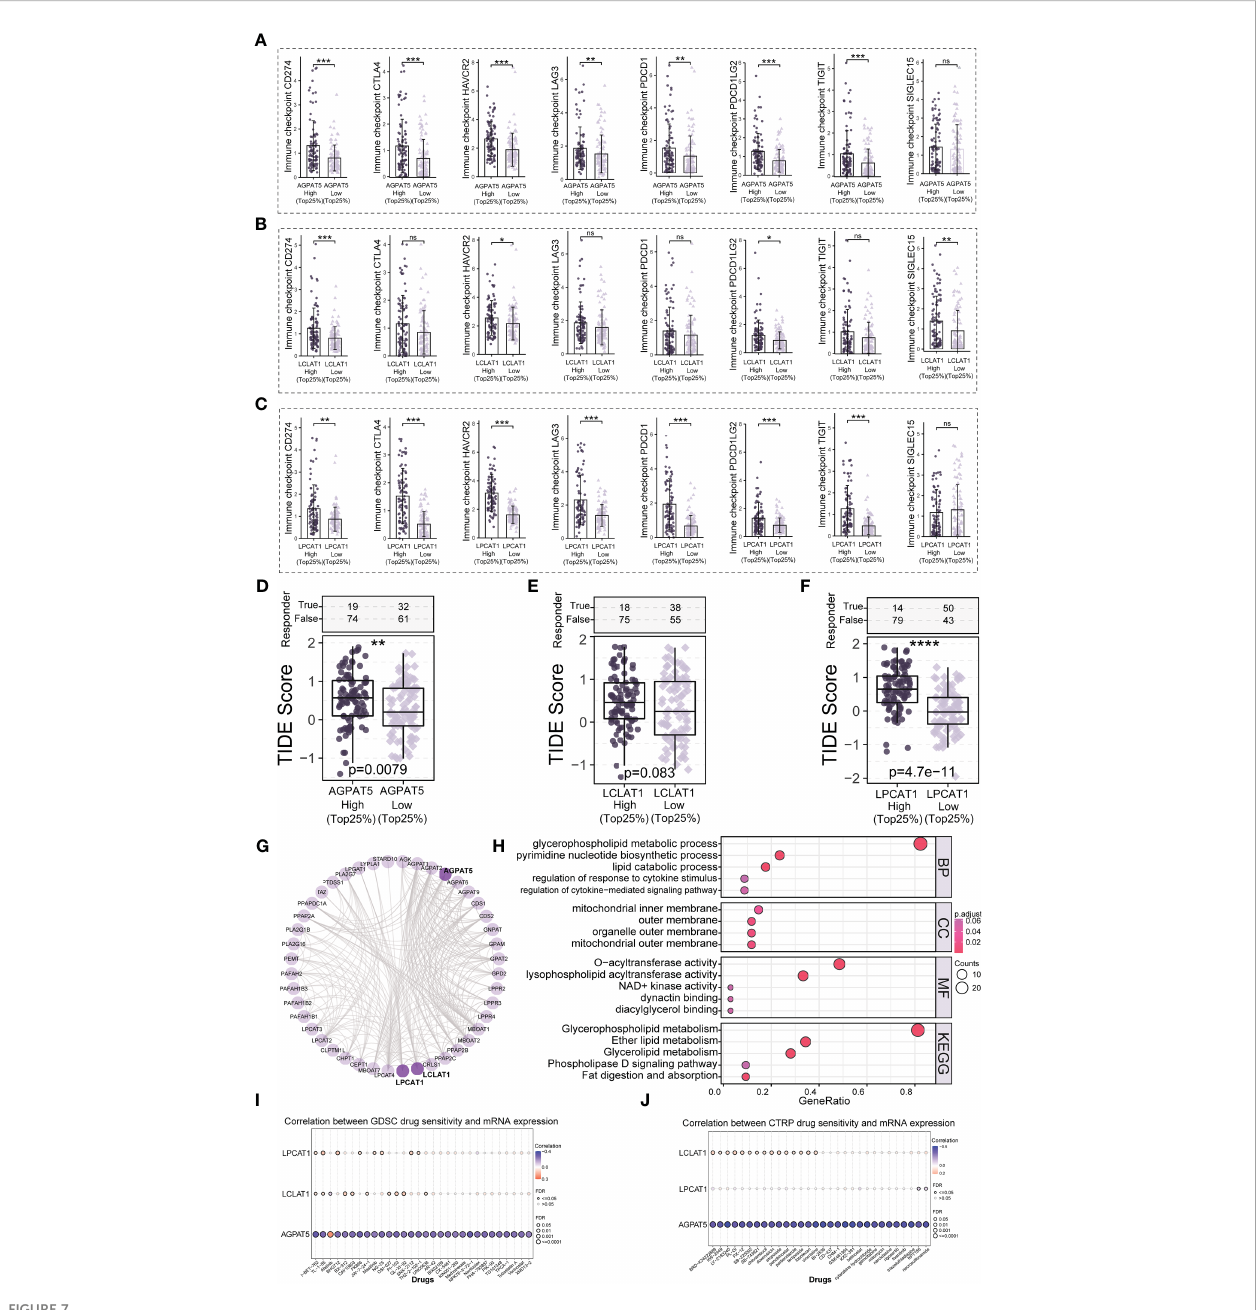
FIGURE 7 Potential immunotherapeutic response and drug sensitivity analysis. (A – C) The expression of eight immune checkpoint-related genes in the high- and low-gene-expression ( AGPAT5 , LCLAT1 , and LPCAT1 ) groups. (D – F) Comparison of TIDE scores in the high- and low-gene-expression ( AGPAT5 , LCLAT1 , and LPCAT1 ) groups. (G) Network diagram of AGPAT5-, LCLAT1-, and LPCAT1-interacting proteins. (H) GO and KEGG enrichment analysis of AGPAT5-, LCLAT1-, and LPCAT1-interacting proteins. (I, J) Bubble plots of the correlation between AGPAT5 , LCLAT1 , and LPCAT1 mRNA expression and drug IC50 values. Signi fi cance signs: ns, p ≥ 0.05; *p< 0.05; **p< 0.01; ***p<